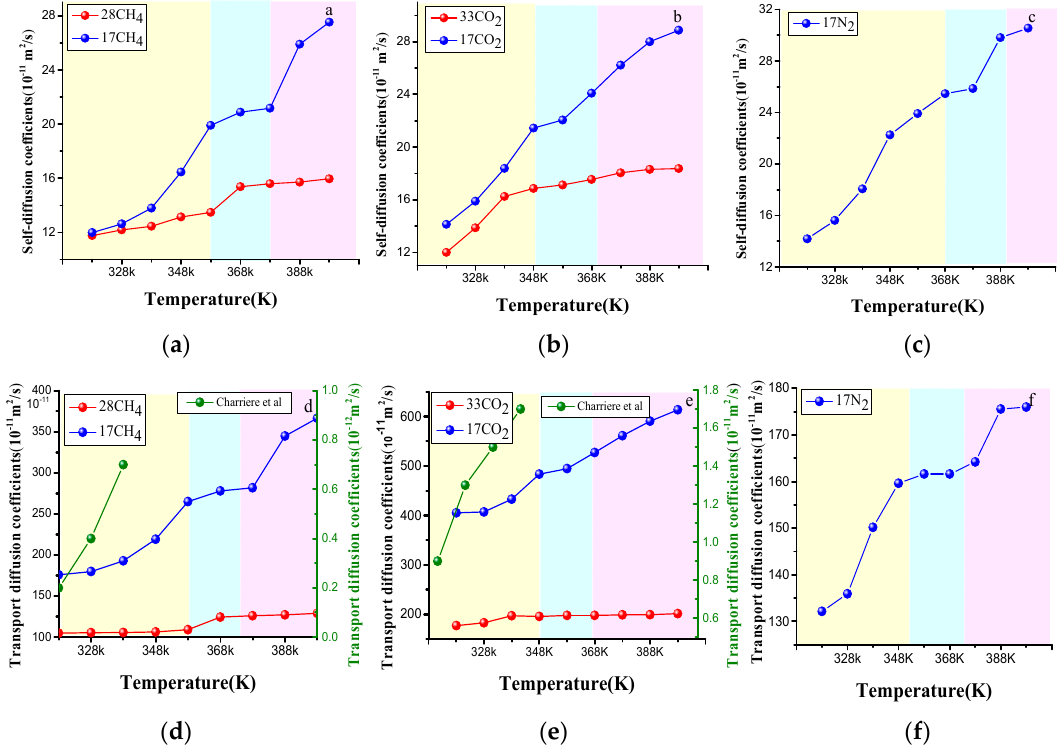
Figure 12. Temperature dependence of the self- and transport diffusion coefficients at 318–398 K obtained through the molecular dynamics (MD) method. ( a ) the variation of CH 4 self-diffusion coefficient with temperature. ( b ) the variation of CO 2 self-diffusion coefficient with temperature. ( c ) the variation of N 2 self-diffusion coefficient with temperature. ( d ) the variation of CH 4 transport diffusion coefficient with temperature. ( e ) the variation of CO 2 transport diffusion coefficient with temperature. ( f ) the variation of N 2 transport coefficient with temperature.